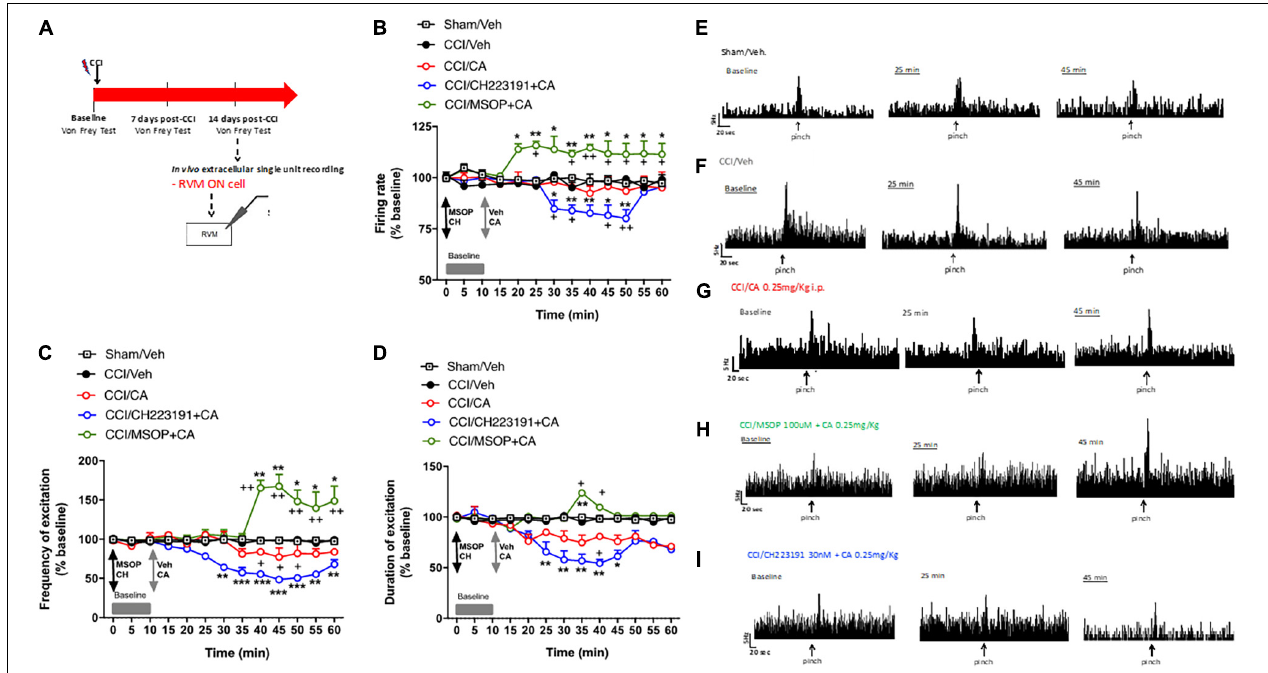
FIGURE 5 | Rostral ventromedial medullary (RVM) ON cell increased activity is oppositely modulated by mGlu4 or aryl hydrocarbon receptor in WT CCI mice. (A) Experimental timeline (top) and graphical representation of extracellular recordings of RVM ON cell in anesthetized mice. (B–D) Mean ± S.E.M population data of intra vl-PAG of MSOP (100 uM) or CH223191 (30 nM) in presence of single systemic injection of cinnabarinic acid (CA, 0.25 mg/Kg) on firing rate (B) , frequency (C) , and duration of excitation (D) of ON cell, in CCI mice. Black arrows indicate MSOP or CH223191 intra vl-PAG microinjections. Grey arrows indicate vehicle or CA intra vl-PAG microinjections. Grey bars indicate interval recordings of basal neuronal activity. Each point represents the mean of 5 different mice per group (one neuron recorded per each mouse). *textitp < 0.05, ** p < 0.01, and *** p < 0.001 indicate statistically significant difference vs. baseline, + p < 0.05 and ++ p < 0.01 indicate statistically significant difference vs. CCI/CA. Two-way ANOVA for repeated measures followed by Tukey’s post-hoc test was used for comparison between groups. Two-way ANOVA for repeated measures followed by Sidak post-hoc test was used for comparison between pre-drug and post-drug values. (E–I) Representative ratemeters showing spontaneous and noxious-evoked activity of ON cell in Sham mice (E) or in CCI mice before and after treatment with vehicle (F) , CA (0.25 mg/Kg) (G) , CH223191+CA (H) , and MSOP+CA (I)